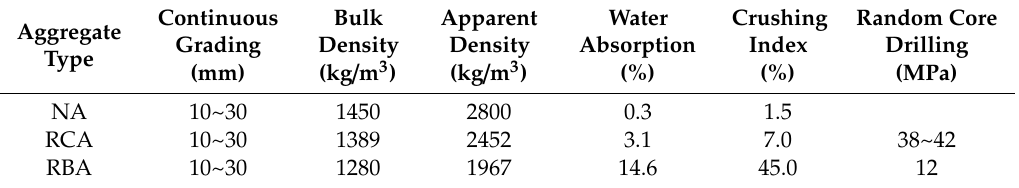
Figure 2. Grading curves of the natural aggregate (NA), RCA and RBA. Table 1. Material properties of coarse aggregates.